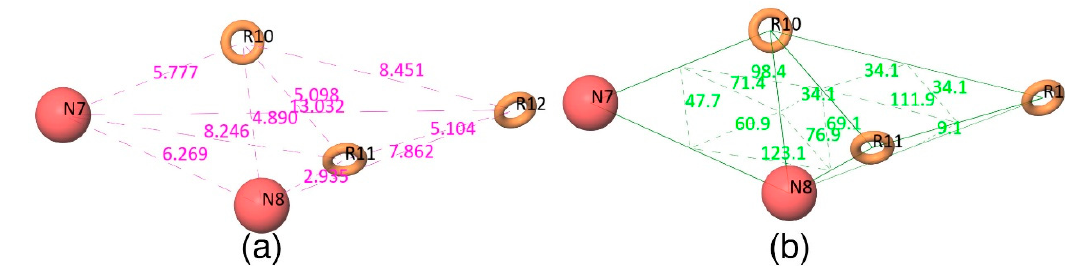
Figure 3. ( a ) Distances and ( b ) angles (Å) measured between the five-point pharmacophore hypothesis (red circles indicate negative sites and brown rings indicate aromatic ring features).